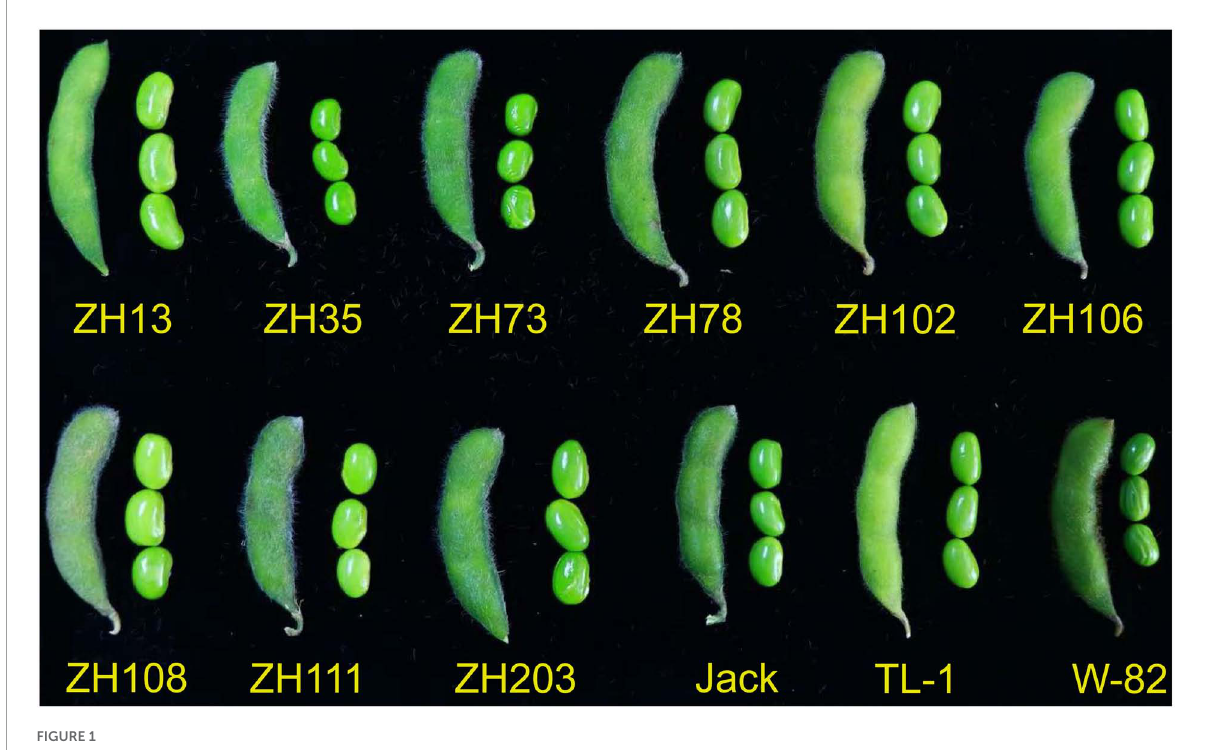
FIGURE1 Soybean cultivars used in the study at the maodou